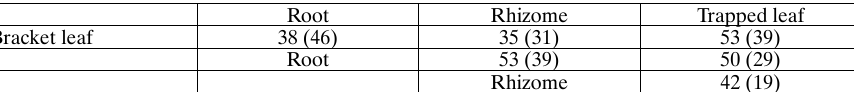
Jaccard’s similarity index (%) of bracket leaf, root, rhizome and trapped leaf of Drynaria of Konaje and Sampaje (in parenthesis)